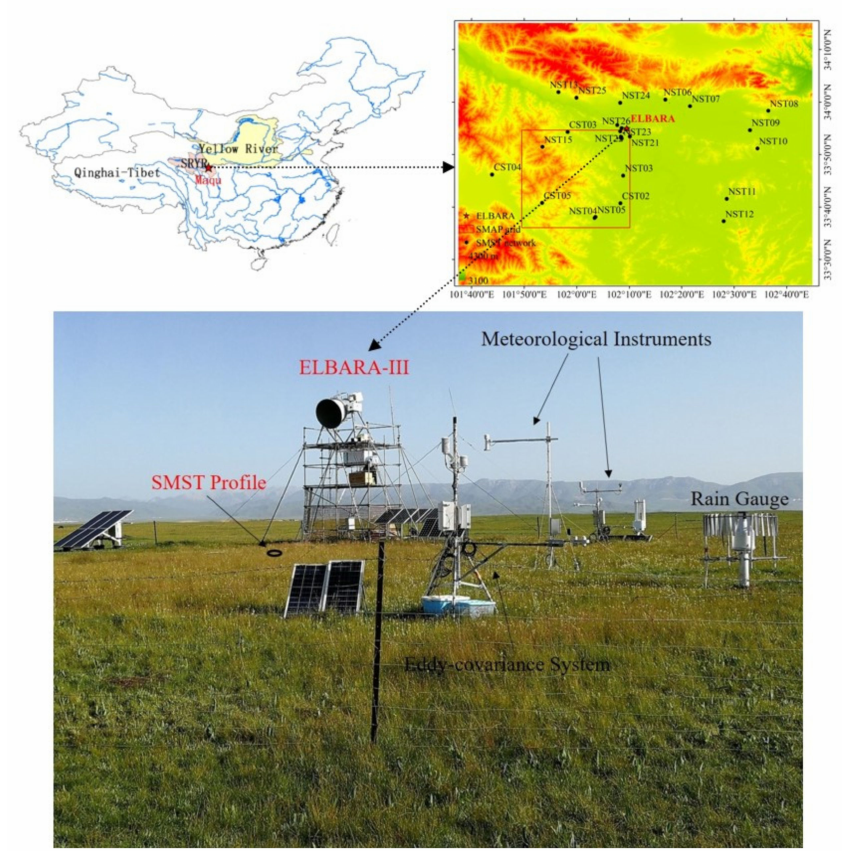
Figure 1. Locations of the Maqu in situ SM network and ELBARA-III monitoring site in the source region of Yellow River